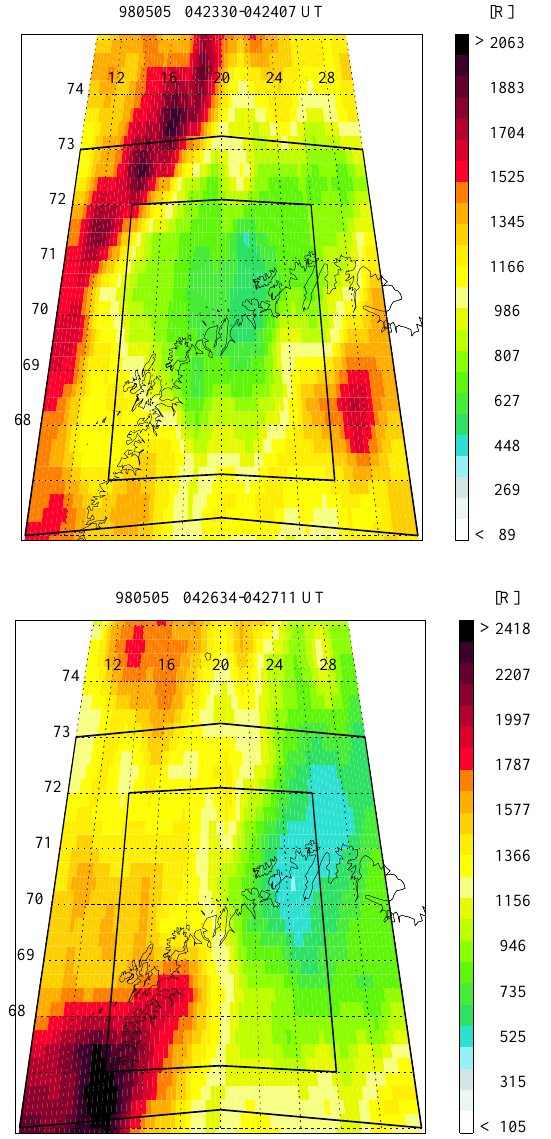
Fig. 4. The UVI-LBHL images for the two time steps of ( a ) 1998. The inner black box drawn on top of the images corresponds to the STARE FOV, while the outer box matches the PIXIE resolu- tion of ∼